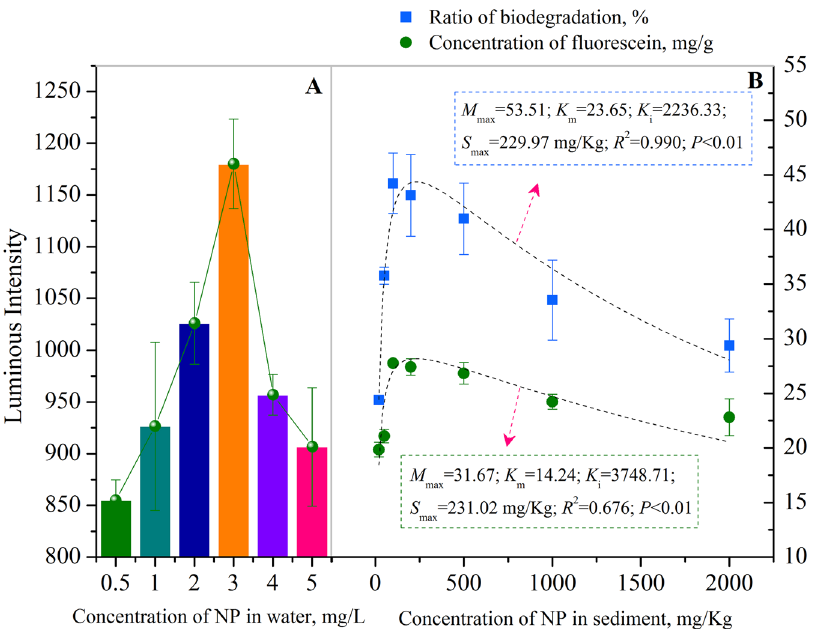
Figure 4. Toxicity of NP in aquatic phase and sediment phase respectively. ( A ) NP toxicity in aquatic phase to luminescent bacteria; ( B ) NP toxicity in sediment phase to FDA hydrolytic activity and NP biodegradation